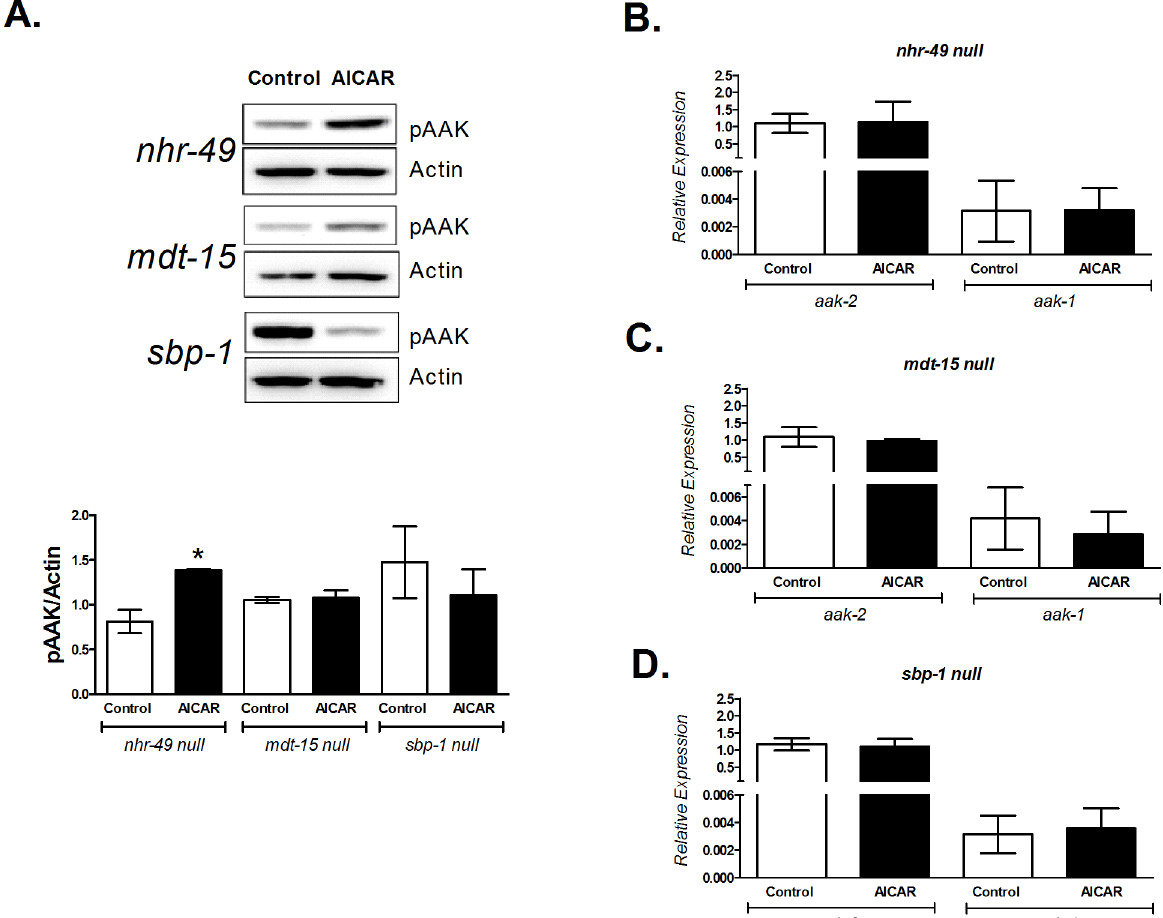
Fig 5. AICAR modifies AAK phosphorylation in mutant strains lacking NHR-49, MDT-15 or SBP-1 transcription factors without altering the expression of both aak-2 and aak-1 . Adult worms of the mutant strains nhr-49/ok2165 , mdt-15/tm2182 and sbp-1/ok2363 lacking the proteins NHR-49, MDT-15 and SBP-1, respectively, were exposed to 1 mM AICAR for 12 h. A) AAK phosphorylation at Thr243; top panel shows a representative Western blot of phosphorylated AAK (pAAK), the graph represents the densitometric analysis. B-D) Relative expression of aak-2 and aak-1 genes normalized to endogenous 18S rRNA gene expression. Each graph shows the mean ± SEM of three independent experiments, ** p < 0.01 vs. untreated group of its own strain, one-way ANOVA with Bonferroni's post hoc test using GraphPad Prism.